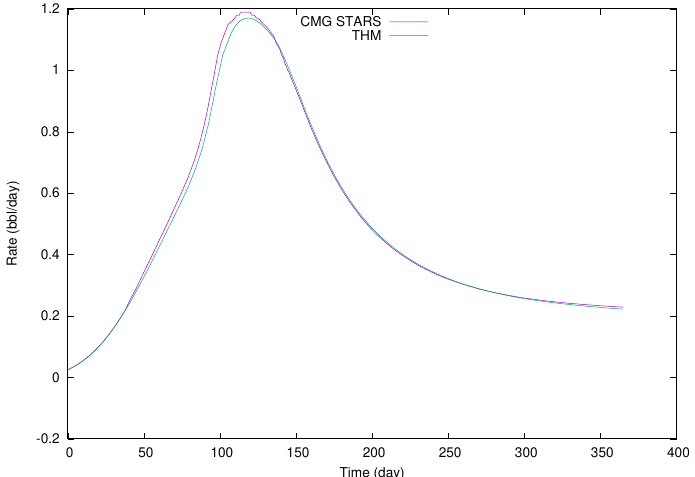
Figure 7. Example 1, oil production rate (bbl/day), second production